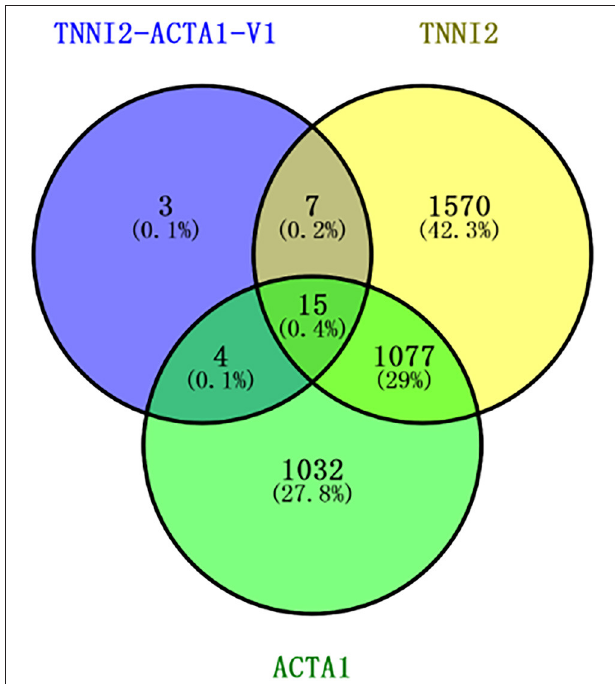
FIGURE 5 | Venn diagram showing the number of specific DEGs genes among these three groups. The blue circle represents the TNNI2-ACTA1 V1 group. The yellow circle represents the TNNI2 group. The green circle represents the ACTA1 group.